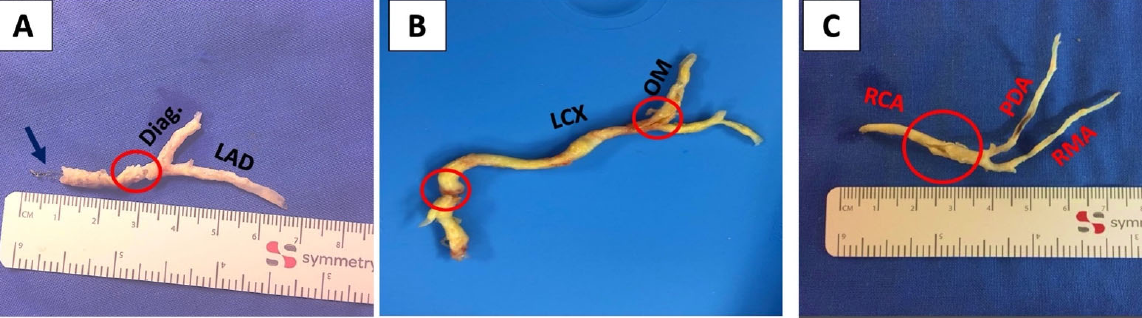
Figure 1. Various atheromatous cylinders extracted from different coronary territories. Legend: The red circle represents the site of incision(s) from ( A ) the LAD territory and its diagonal, where the black arrow indicates a stent that was extracted from within the atheroma; ( B ) the LCX territory and its marginal branch, where the cylinder was disrupted and a second incision was needed; and ( C ) the RCA territory. Diag = Diagonal branch, LAD = Left anterior descending artery, LCX = Left cir ‐ cumflex artery, OM = Obtuse marginal, RCA = Right coronary artery, PDA = Posterior descending artery, RMA = Right marginal artery